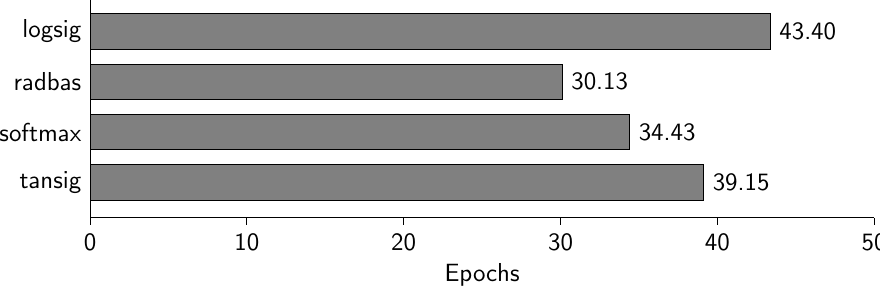
Figure 11. Number of epochs until the end of the learning process.